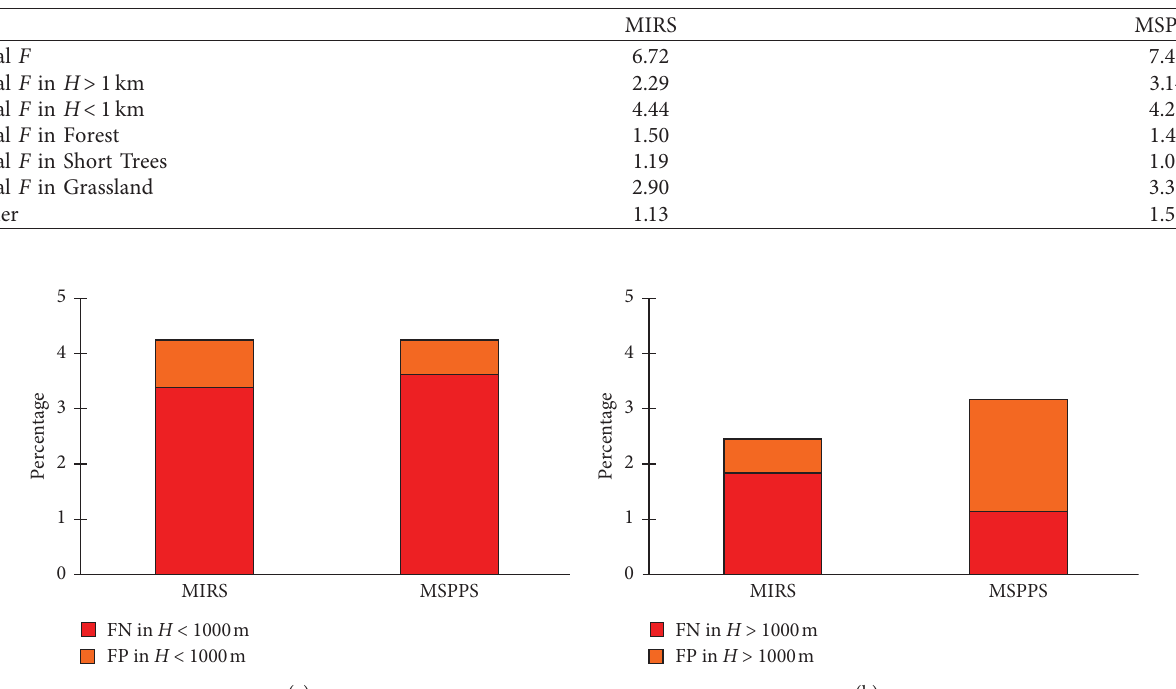
Figure 10: Percentage of false positive (FP) and negative (FN) classification present in (a) low elevation ( < 1000m) and (b) high elevation ( > 1000m